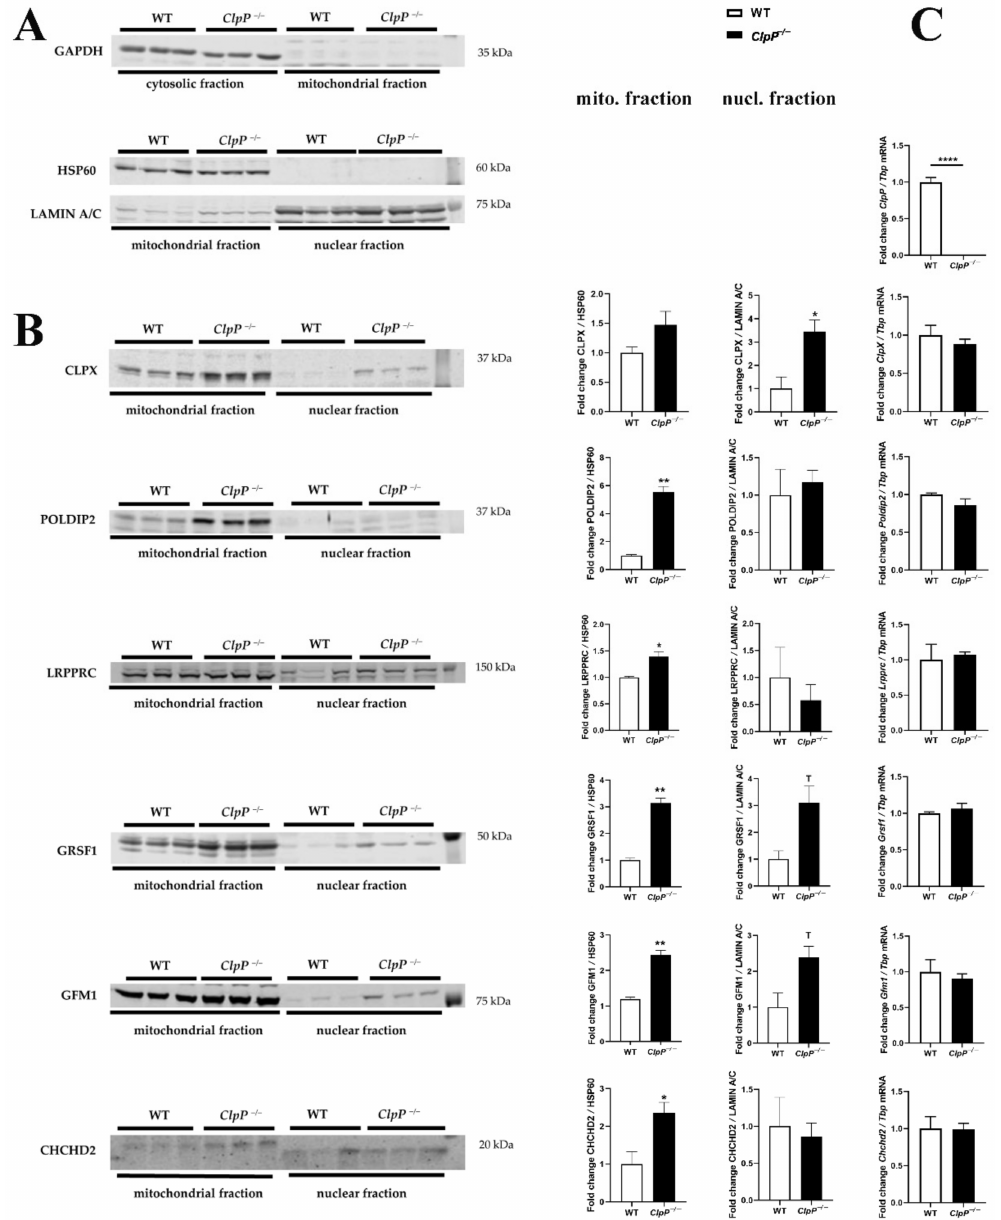
Figure 3. Analyses of redistribution of mitochondrial factors to the nucleus. ( A ) Quantitative immunoblots were used to control subcellular fractionation quality and loading by GAPDH, HSP60, or LAMIN A/C protein abundance. ( B ) Immunoblot validation of protein accumulation in mitochondrial and nuclear fractions (membrane at left margin, bar graph in center). ( C ) Assessment of underlying transcript levels by RT-qPCR (right margin) for specific ClpX interactors in ClpP − / − ( n = 3) versus WT ( n = 3) mouse embryonal fibroblasts. * p < 0.05, ** p < 0.01; **** p < 0.0001; T represents 0.05 < p <